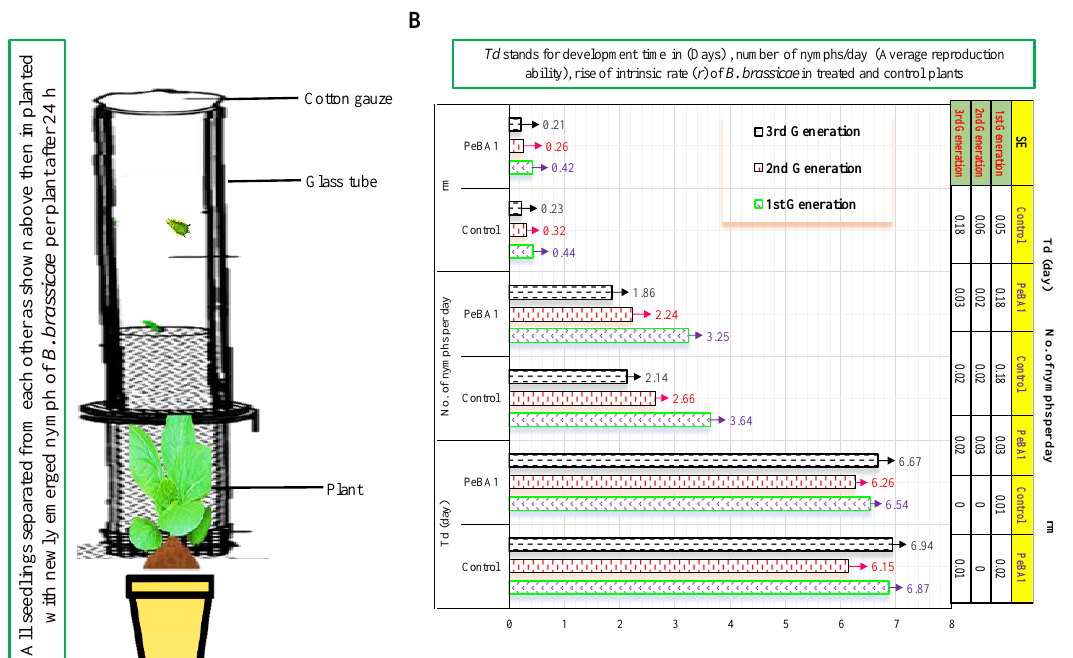
Figure 3. Development time, reproductive capacity, and rate of growth of B. brassicae ( A , B ) in seedlings treated with PeBA1 and control (mean ± SD). The study used a randomized (CRD) statistical design, SPSS 18.0 was used to compare data by LSD and one-way ANOVA, ( p = 0.05).